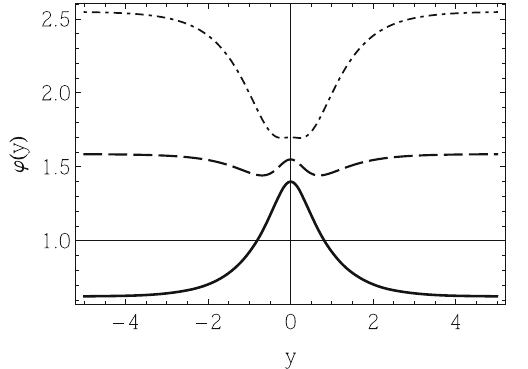
Fig. 6 Kink solution obtain by Eq. (31) for n = 1 (solid line), n = 2 (dashed line) and n = 20 (dot-dashed